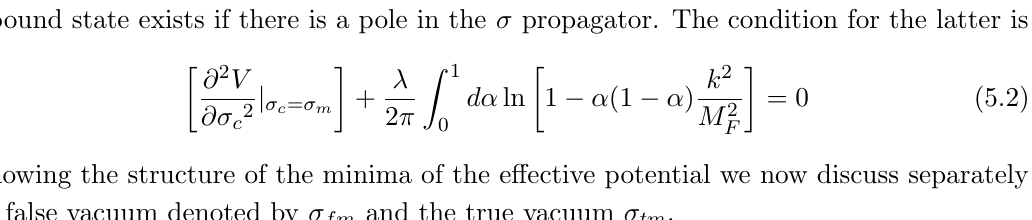
as a function of g(cid:27) c m 2